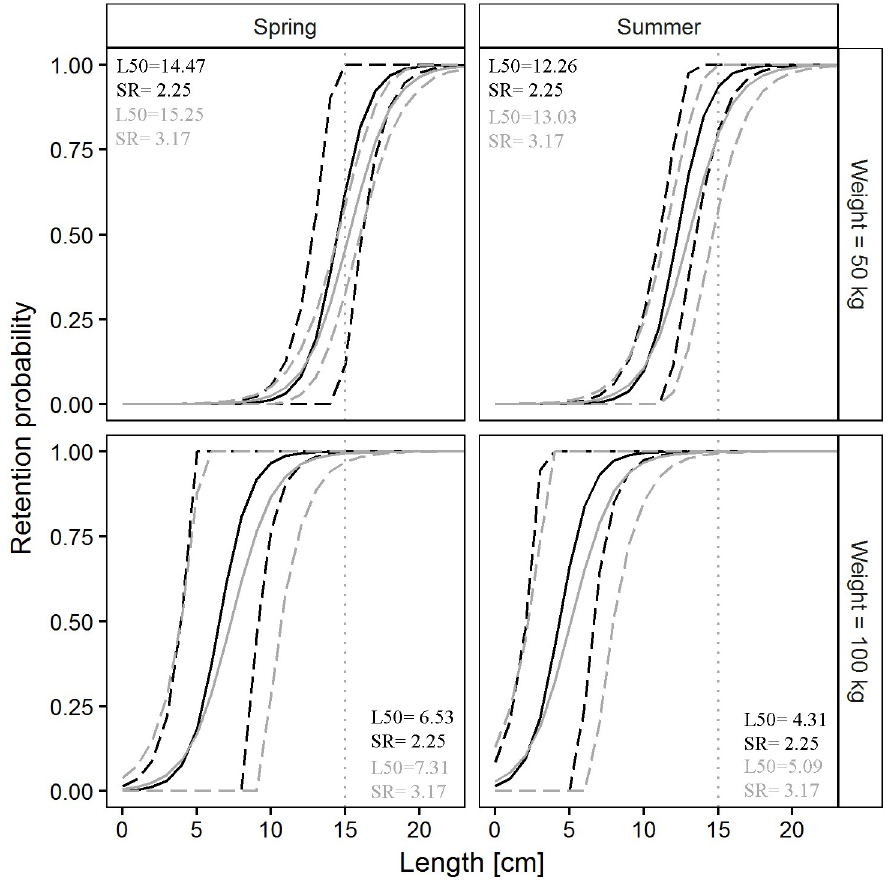
Fig 3. Differences in Atlantic horse mackerel retention probability between the SM40 (black) and the DM50 (grey) codend in four simulated scenarios. Dashed lines: 95% CI for the mean curve (solid line); dotted vertical line: MCRS for Atlantic horse mackerel (TL, 15